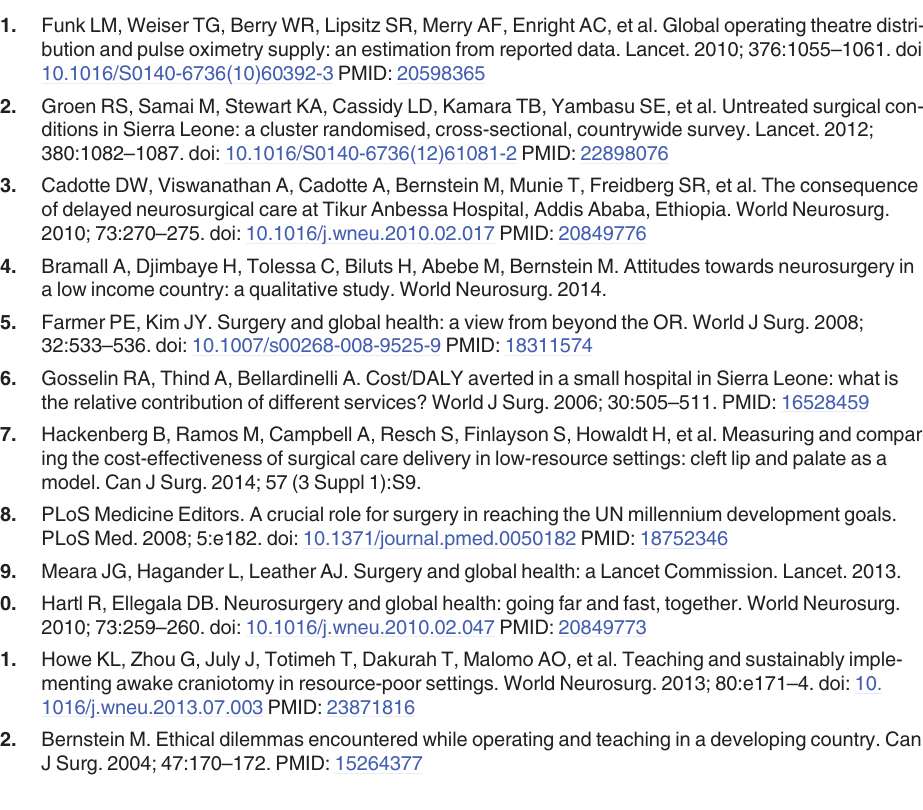
S1 Table. Semi-structured questions to surgeons from developed and LMICs. S2 Table. Sample analysis of interview